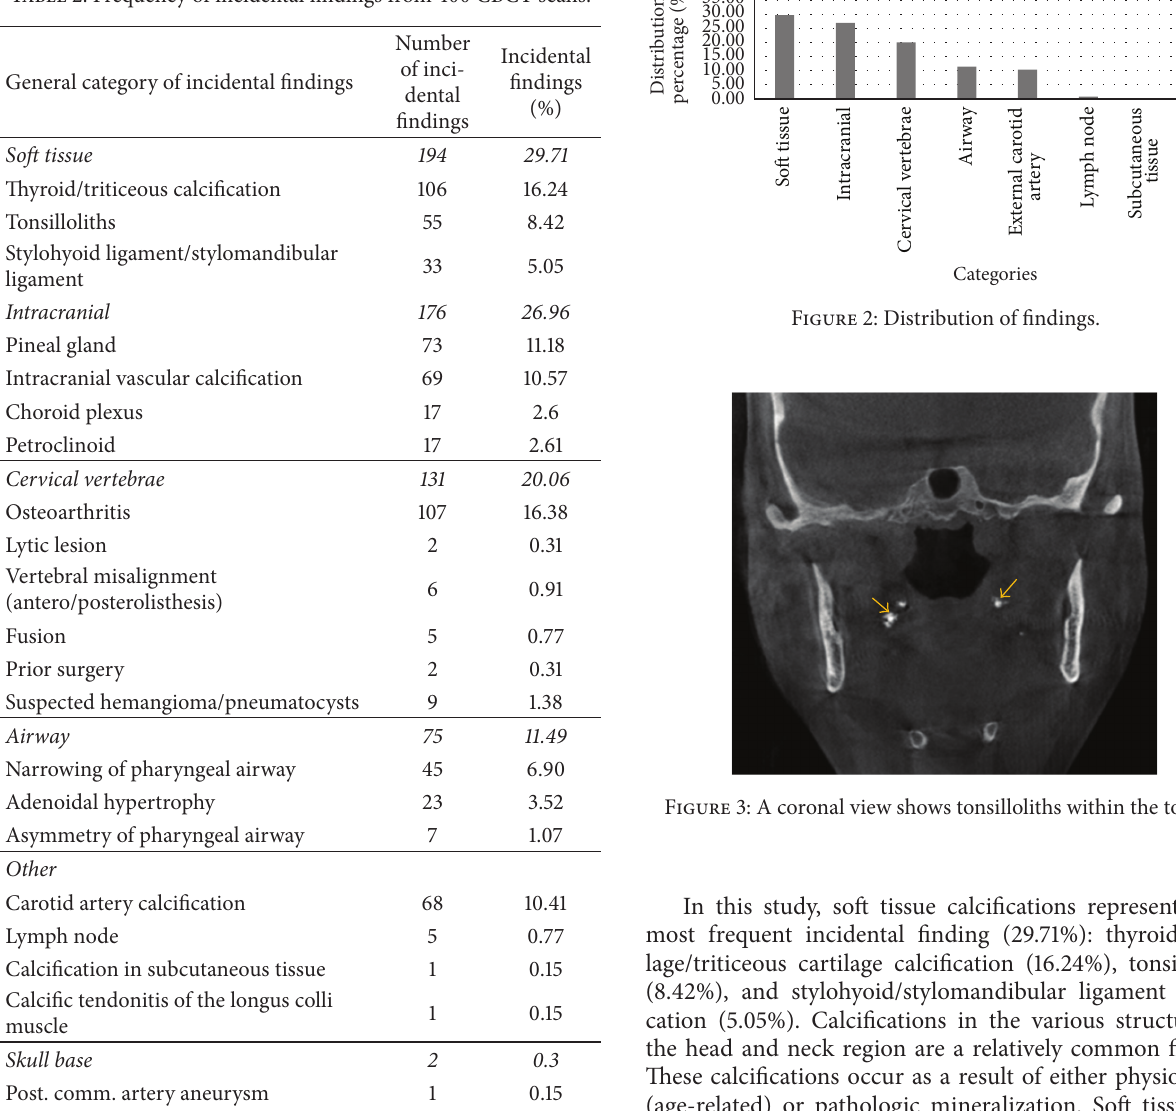
Table 2: Frequency of incidental findings from 400 CBCT scans.